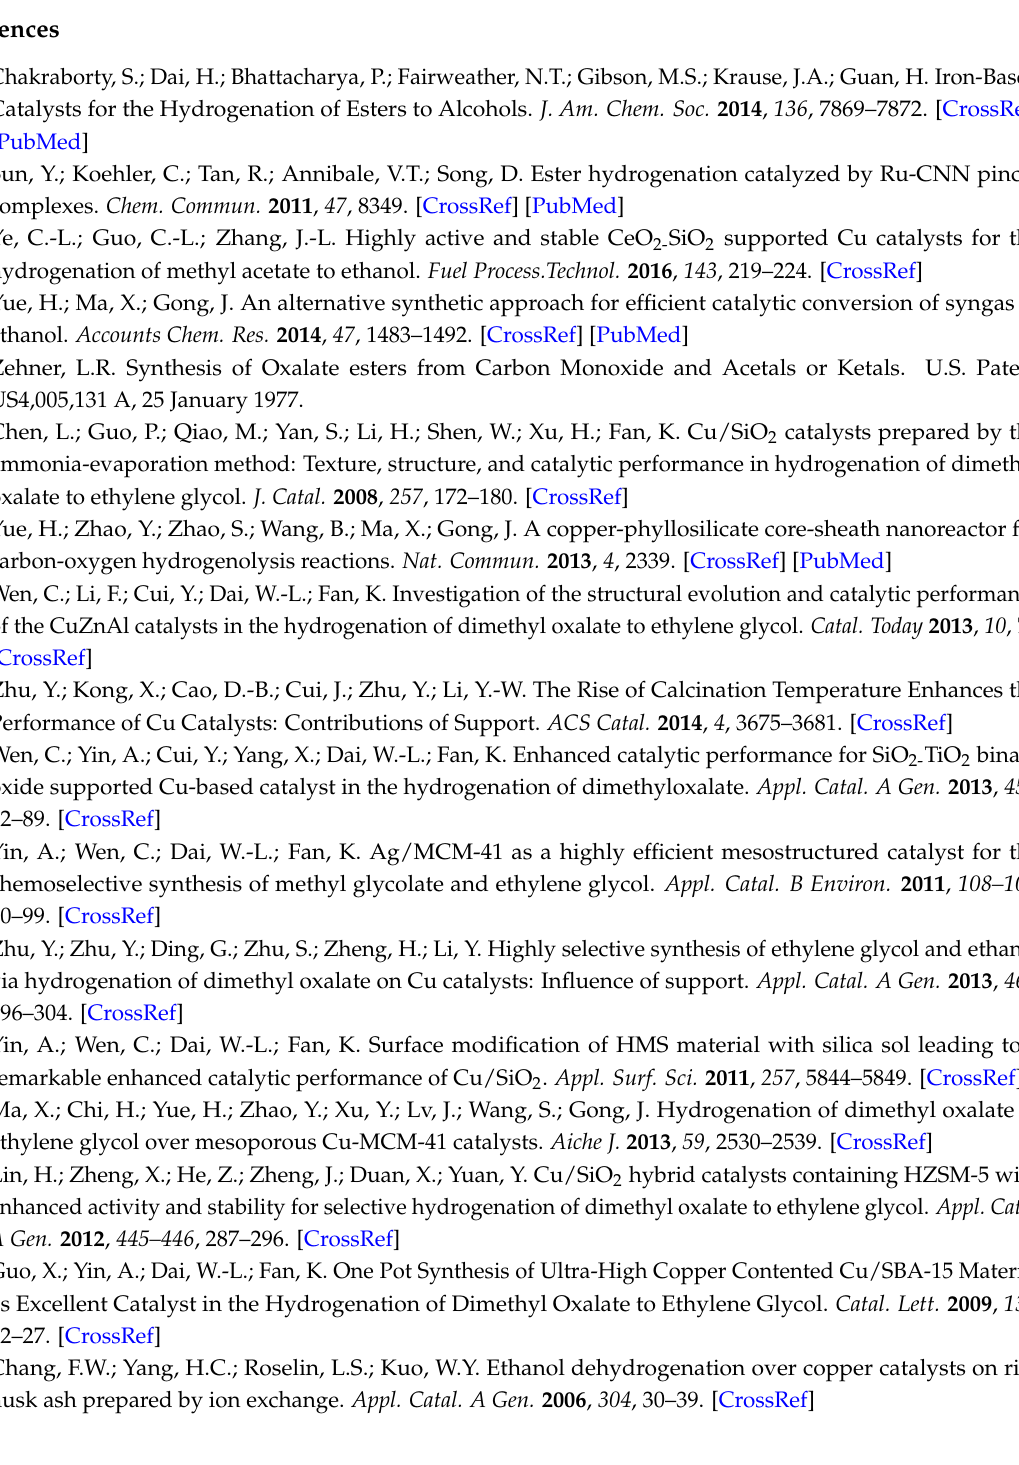
Supplementary Materials: The following are available online at http://www.mdpi.com/2073-4344/7/3/75/s1, Figure S1: TPOs of the spent catalysts for 8 hours of reaction, Figure S2: (A) N2 adsorption–desorption isotherms, and (B) BJH pore size distributions of calcined supports. Table S1: